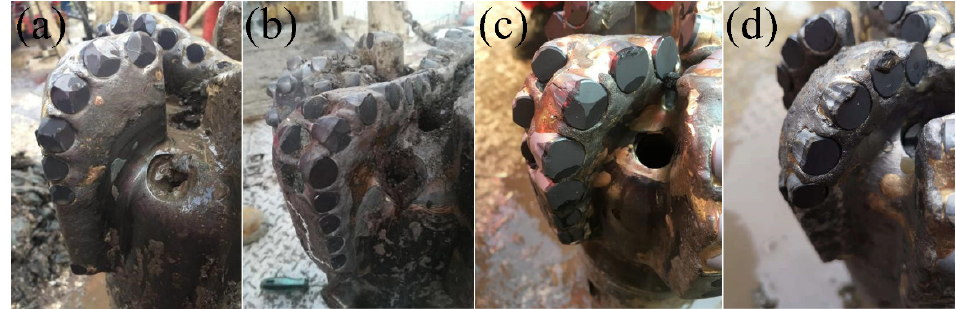
Figure 21. Pictures of bits after field trials: ( a ) 3-RDE PDC bit in gravel formation; ( b ) Hybrid bit in gravel formation; ( c ) 3-RDE PDC bit in granite formation; ( d ) Conventional PDC bit in granite formation.